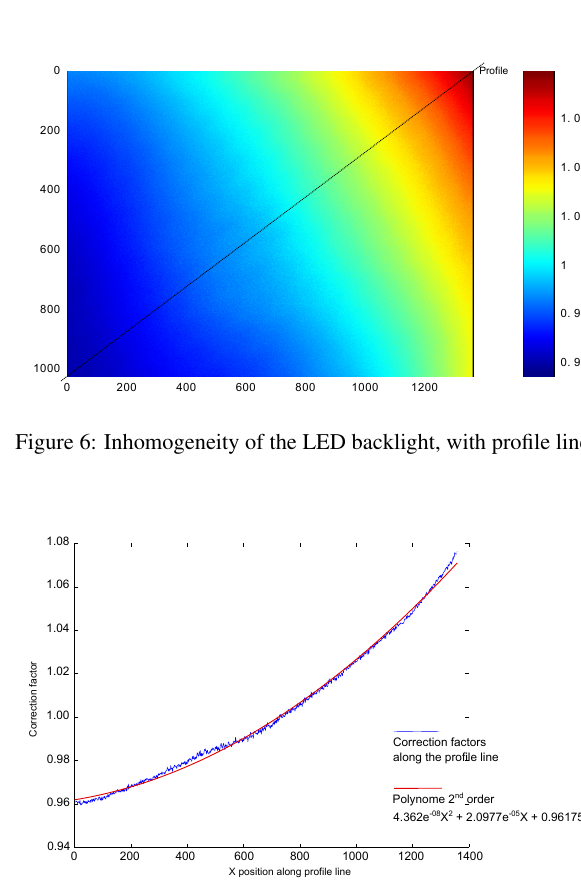
Figure 5: Flat field correction matrix (FFC) calculated from the integrating sphere.